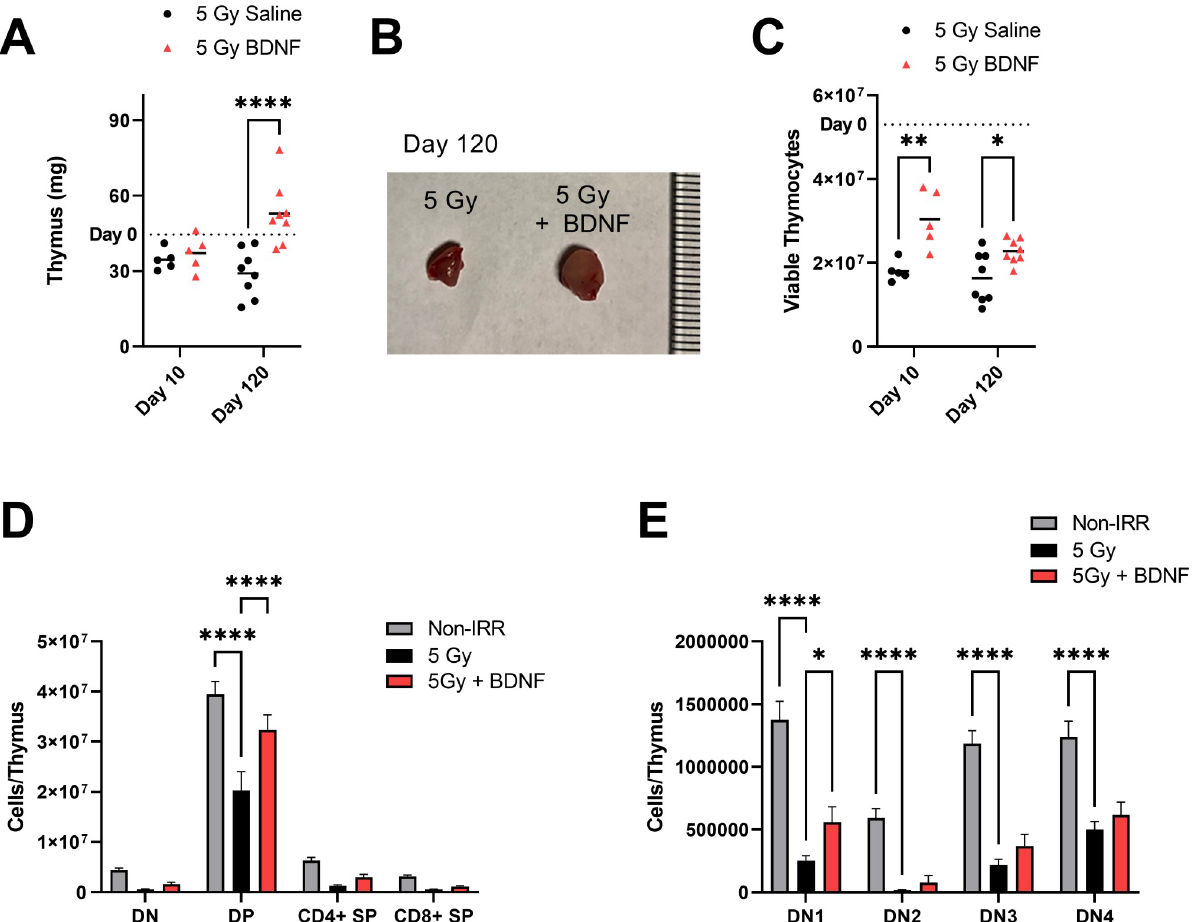
Fig 5. BDNF administration promotes thymic regeneration following TBI. (A) Thymus weights at days 10 and 120 following irradiation and treatment with BDNF. (B) Representative day 120 thymi. (C) Total viable thymocytes at days 10 and 120. (D) Total numbers of double negative (DN), double positive (DP), CD4+ single positive, and CD8+ single positive cells at day 10. E, Total numbers of DN1, DN2, DN3, and DN4 thymocyte precursors at day 10. (Day 10: n = 5 mice per group). Shown are mean values + SEM. � P < .05, �� P < .01, ���� P < .0001.